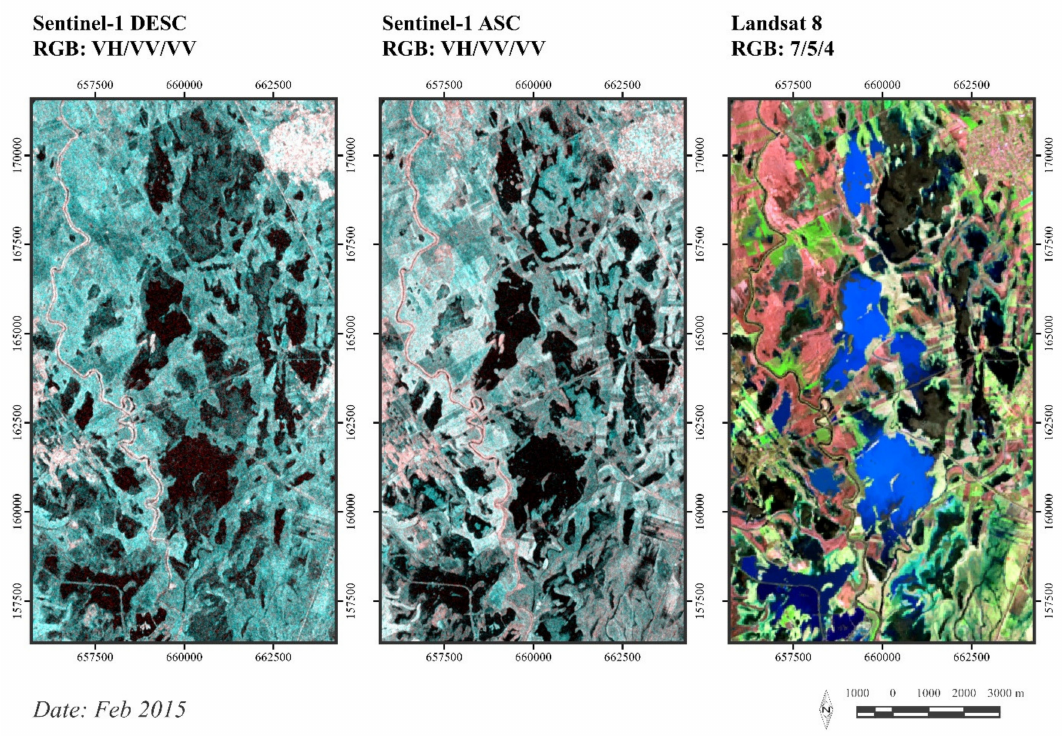
Figure 11. Comparison of Sentinel-1 radar and Landsat 8 surface reflectance composites for February 2015—RGB: 7 / 4 / 3 denotes the combination of SWIR / NIR / visible red satellite image bands; SWIR: short-wave infrared band at λ = 2.1 µ m; NIR: near-infrared band at λ = 0.8–0.9 µ